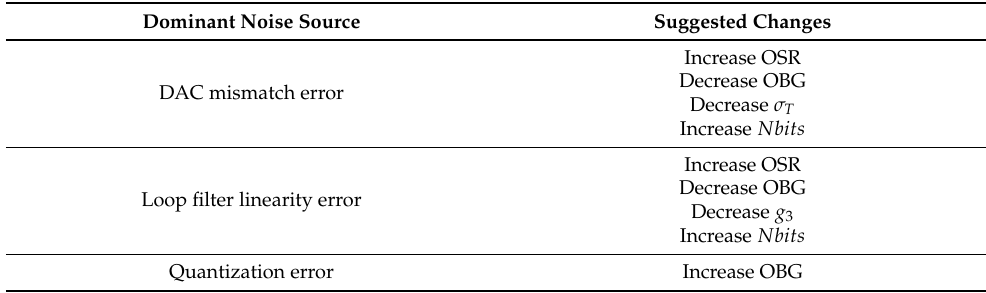
Table 3. Suggested modifications to reduce IBN power in NP